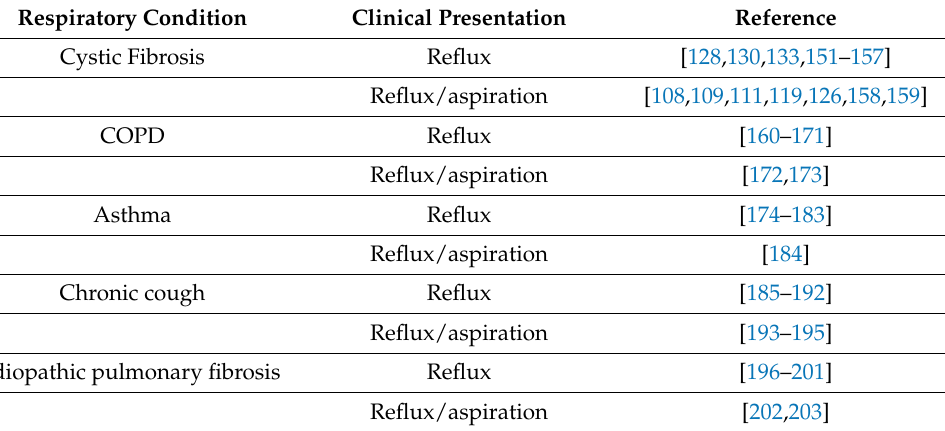
Table 1. Literature review of the association of gastro-oesophageal reflux and aspiration with a range of respiratory